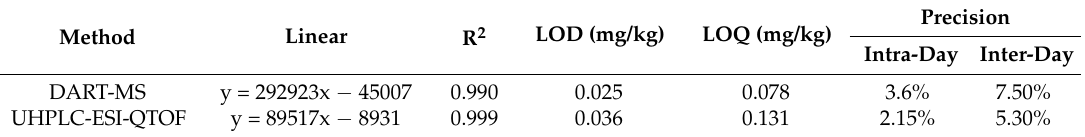
Table 1. The validation parameters of DART-MS versus UHPLC-ESI-QTOF method.